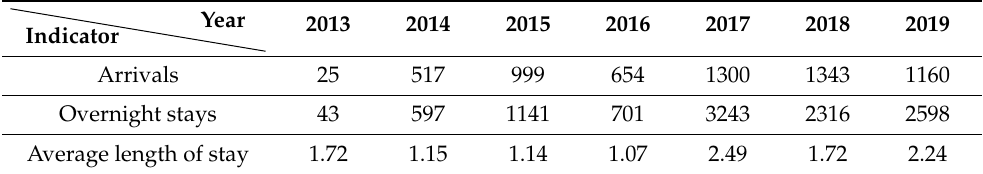
Table 1. Tourist activity in the Rodna